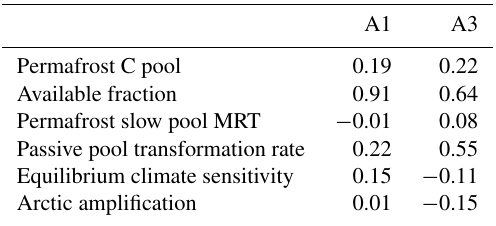
Table 3. Correlation coefficients between perturbed model param- eters and the anomaly in ZEC 50 years after emissions cease. Stronger correlation indicates increased influence for a given pa- rameter. MRT is mean residence